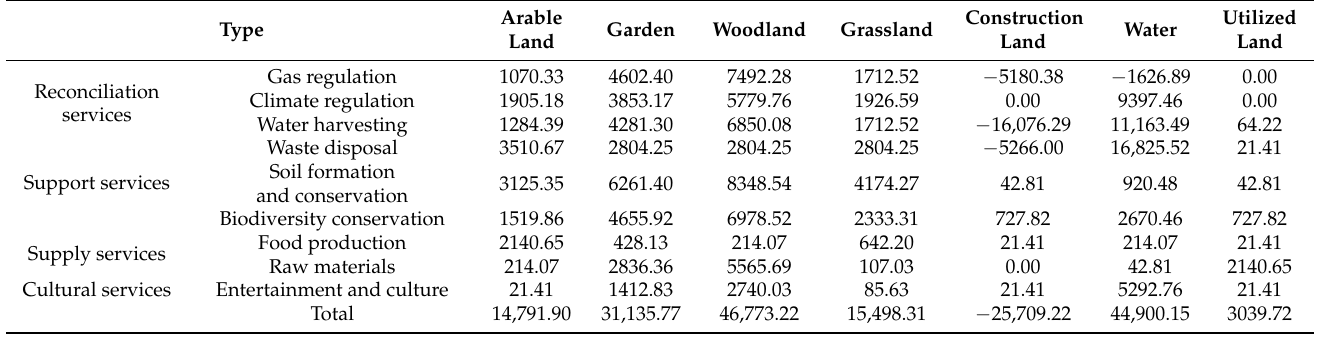
Table 1. Table of ecosystem service value coefficients (VC) in Xintai (CNY/hm 2 ·